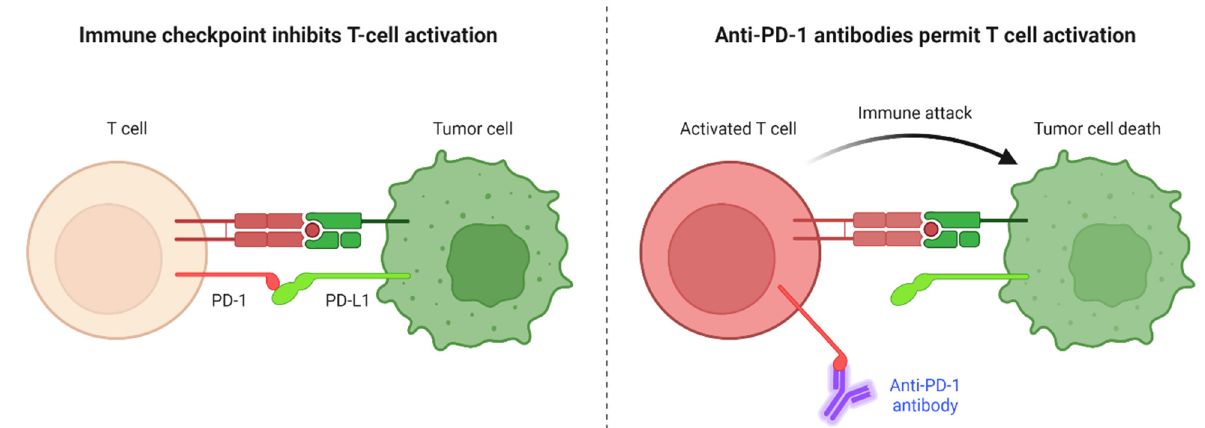
Figure 3. Immune checkpoints inhibit T cell activation in the cancer microenvironment, upon ligation of programmed cell death protein 1 (PD-1) expressed by T cells to its ligand programmed death ligand 1 (PD-L1) on cancer cells. Anti-PD-1 monoclonal antibodies interfere with PD-1/PD-L1 interaction and permits T cell activation and lysis of cancer cells. Figure created using Biorender.com.